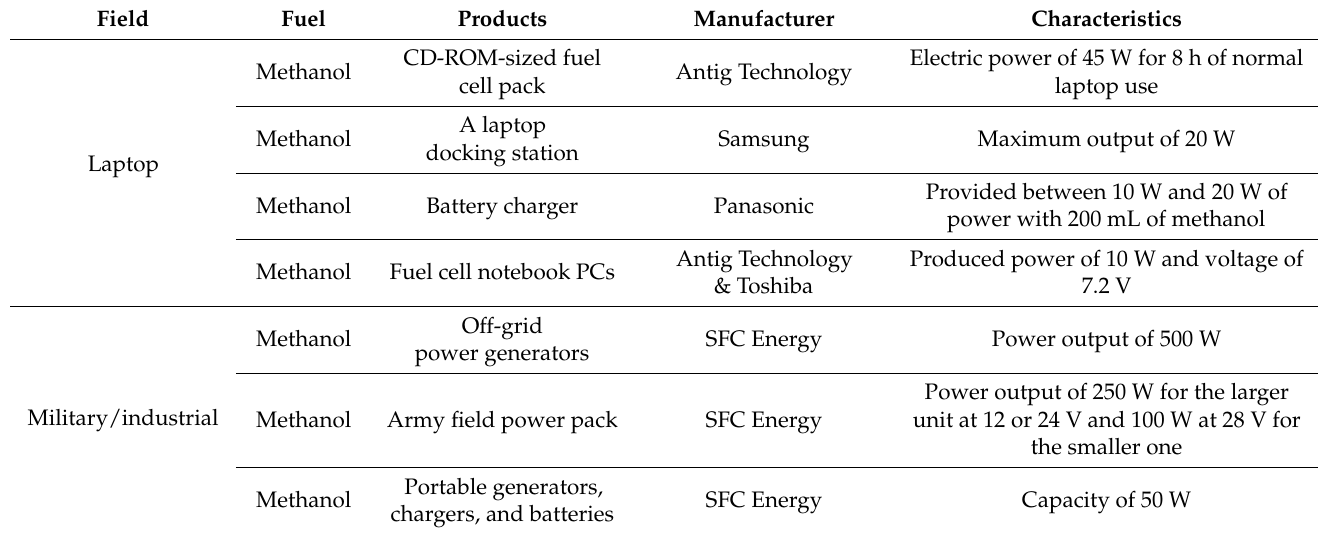
Table 1. DAFC portable commercial applications. Reproduced from [18] with permission from